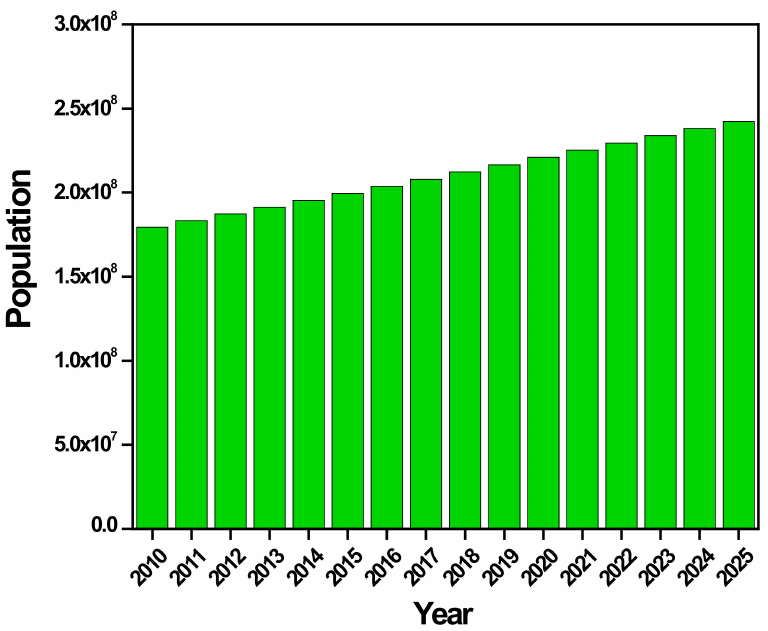
Figure 1. Pakistan’s population from 2010 to 2020, along with predictions until 2025 [3].